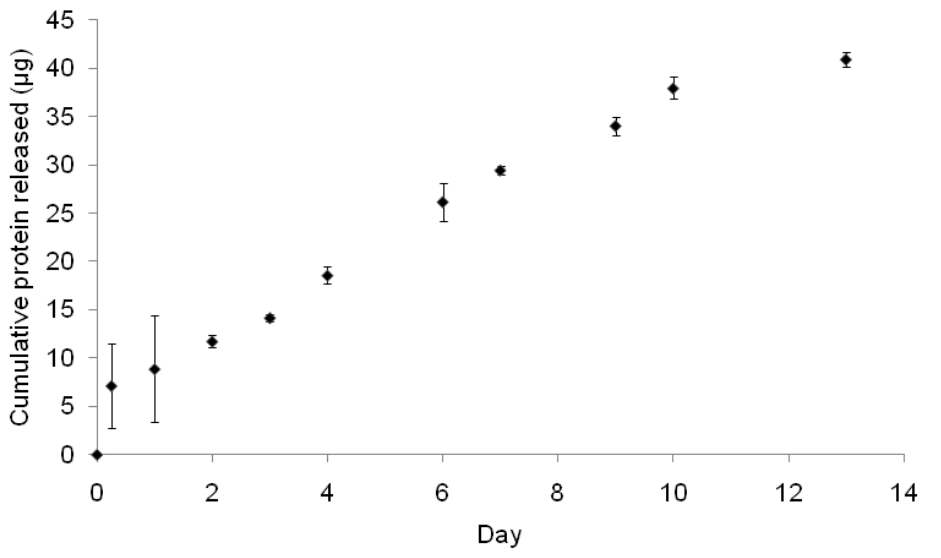
Figure 3. Release curve showing the cumulative protein release from microparticles over a 13 day release period. Protein was quantified using a bicinchoninic acid (BCA) assay. Error bars are ±1 SD (n =